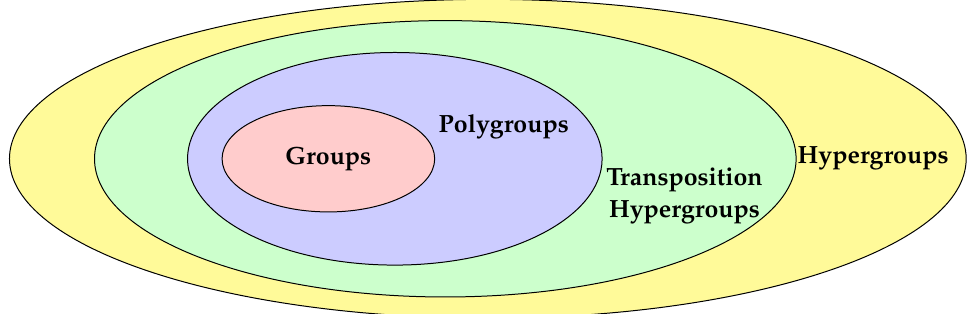
Figure 1. Each group is a polygroup, each polygroup is a transposition hypergroup, and each transposition hypergroup is a